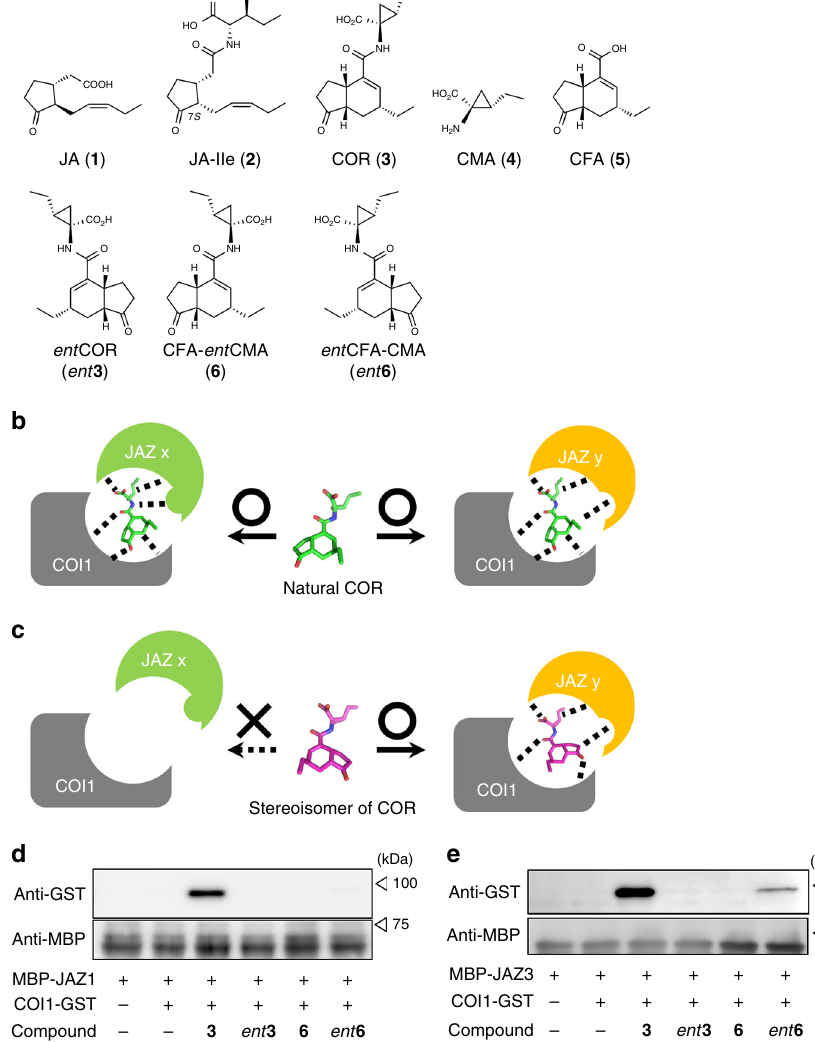
Fig. 1 One stereoisomer of COR is a potential JAZ subtype-selective agonist. a Chemical structures of jasmonate derivatives and coronatine diastereomers. b, c Schematic diagram of ligand-induced protein-protein interactions (PPIs) between COI1-JAZ co-receptors; b naturally occurring ligands (i.e., coronatine) can interact with all co-receptors, whereas c the stereochemical isomer (used in this study) can interact with only some co-receptors. d, e Pull down assay of puri fi ed GST-COI1 (5 nM) with recombinant proteins expressed in E. coli , including d MBP-JAZ1 (full length, approximately 40 nM), and e MBP-JAZ3 (full length, approximately 40 nM), in the presence of COR derivatives (100 nM). GST-COI1 bound to MBP-JAZ proteins was pulled down with amylose resin and analyzed by immunoblotting. Goat HRP-conjugated anti-GST antibody was used to detect GST-COI1 (black triangles). Rat anti-MBP antibody and goat HRP-conjugated rat-IgG antibody were used to visualize MBP-JAZ protein levels as the input materials (white